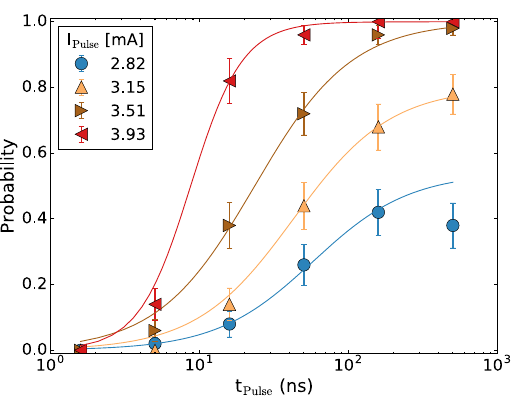
Figure 3. The generation probability versus pulse duration for different pulse amplitudes. The dc current was fixed at 13.5 mA and a 0.7 T field was applied. The lines are guides to the